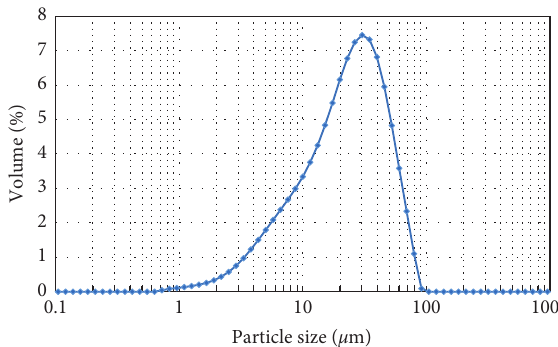
Figure 1: Particle size distribution of powdered activated carbon.